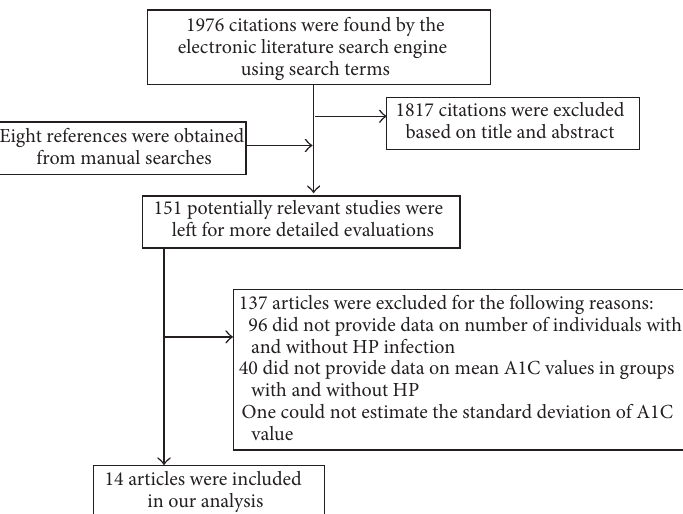
Figure 1: Flow chart of meta-analysis. HP: Helicobacter pylori ; A1C: hemoglobin A1C.